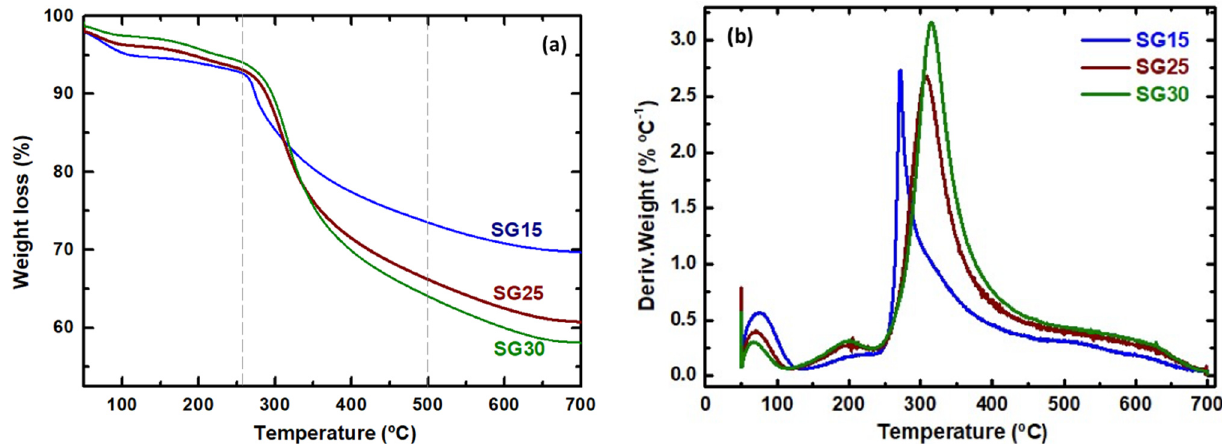
Figure 3. ( a ) Thermogravimetric curves and ( b ) derivative weight losses of the